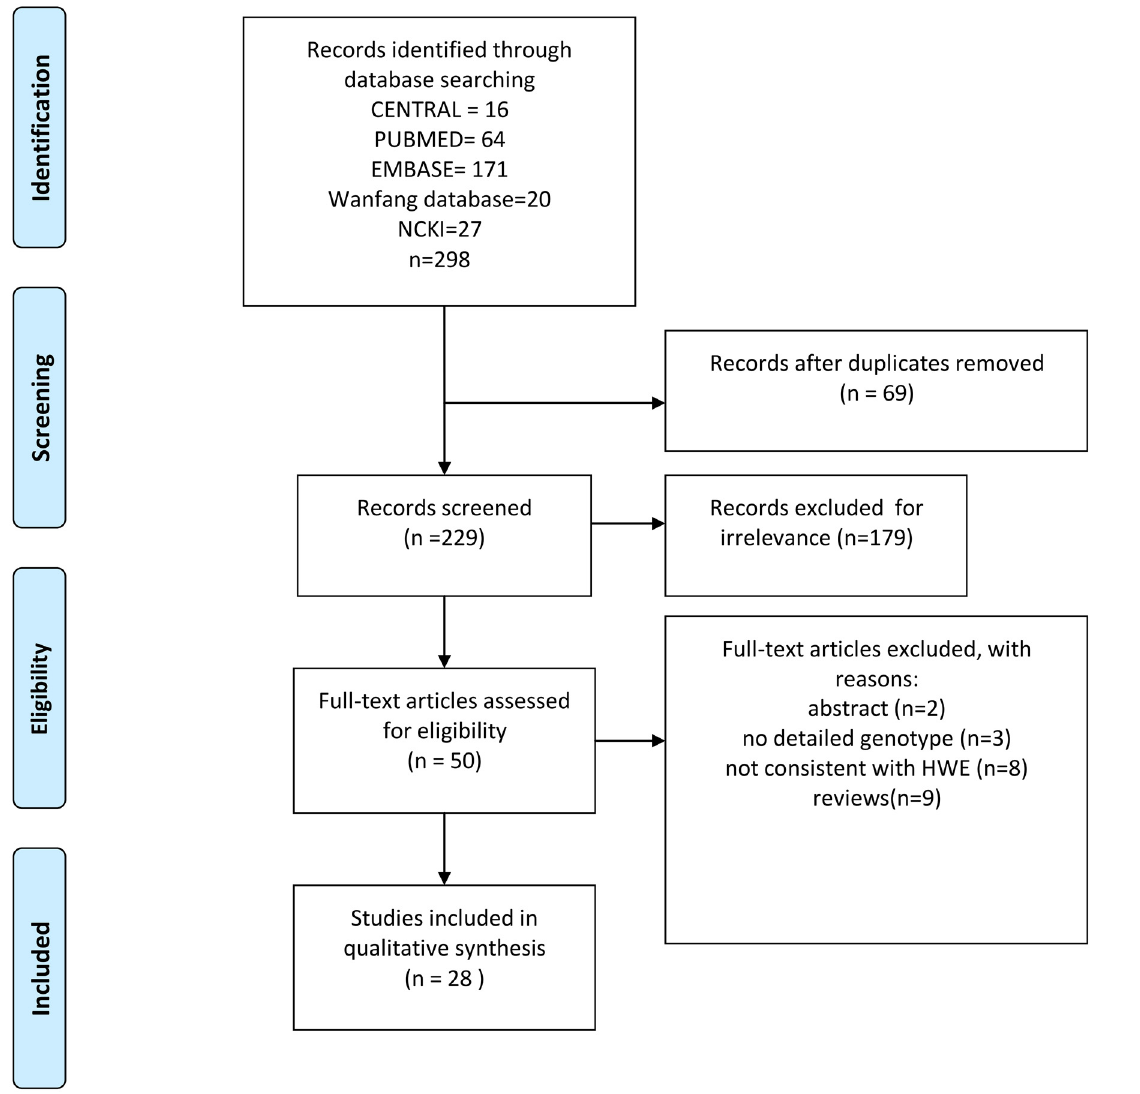
Fig 1. Flow chart depicting the study selection